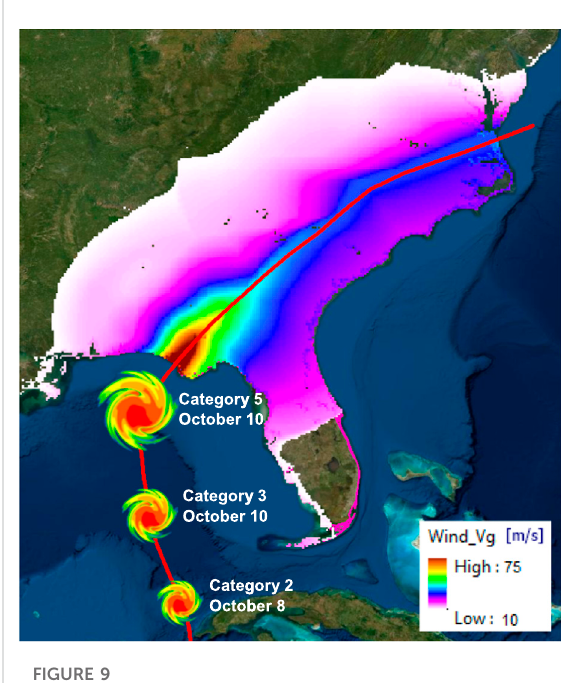
FIGURE 9 The evolution of Hurricane Michael in the Gulf of Mexico and its landfall on the US along with the spatial variation of wind speed across the southeast of the